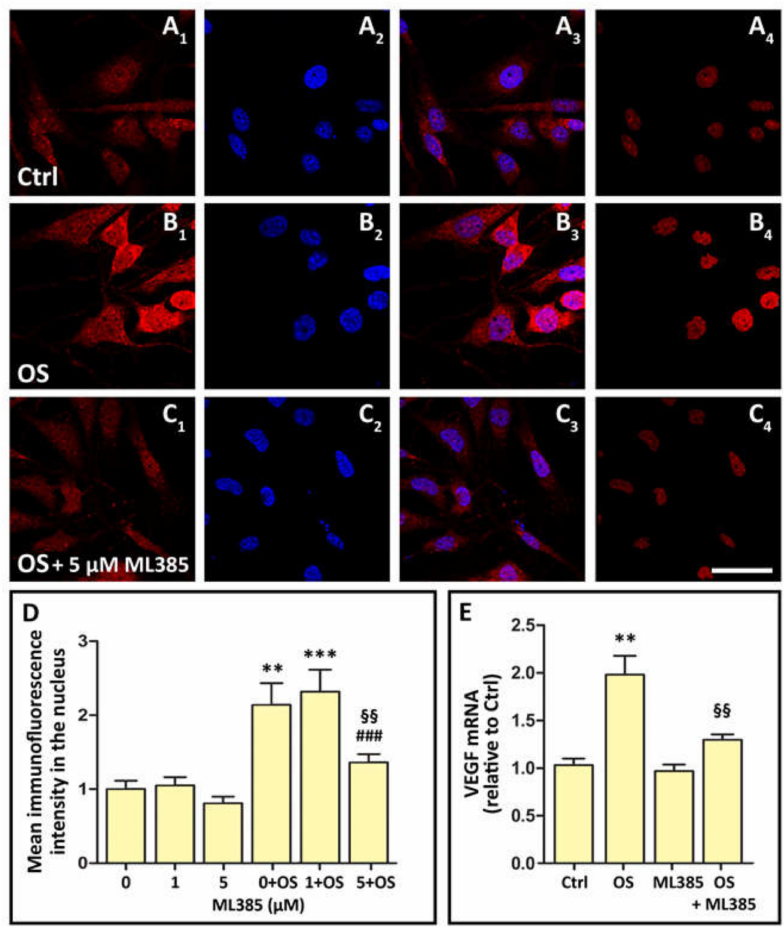
Figure 5. Immunofluorescence images documenting nuclear factor erythroid 2-related factor 2 (Nrf2) production and nuclear translocation in Ctrl, OS-treated (OS) and in OS-treated MIO-M1 cells incubated in the presence of the Nrf2 inhibitor ML385 at 5 µ M (OS + ML385). ( A1 ), ( B1 ) and ( C1 ) show the overall Nrf2 immunostaining of MIO-M1 cells in the three di ff erent conditions; ( A2 ), ( B2 ) and ( C2 ) show the Hoechst-stained cell nuclei; ( A3 ), ( B3 ) and ( C3 ) are merged images of the previous two; ( A4 ), ( B4 ) and ( C4 ) show Nrf2 immunostaining limited to the cell nucleus. Scale bar, 50 µ m. The histograms in ( D ) represent the quantification of immunofluorescence intensity within the nuclei of MIO-M1 cells in the di ff erent experimental conditions. The values are relative to that corresponding to 0 µ M ML385. ** p < 0.01 and *** p < 0.001 relative to 0 µ M ML385; §§ p < 0.01 relative to OS + 0 µ M ML385; ### p < 0.001 relative to OS + 1 µ M ML385. The histograms in ( E ) represent VEGF mRNA expression in MIO-M1 cells exposed to OS for 24 h and e ff ect of the Nrf2 inhibitor ML385. ** p < 0.01 relative to Ctrl; §§ p < 0.01 relative to OS. n = 8 in ( D ); n = 3 in ( E